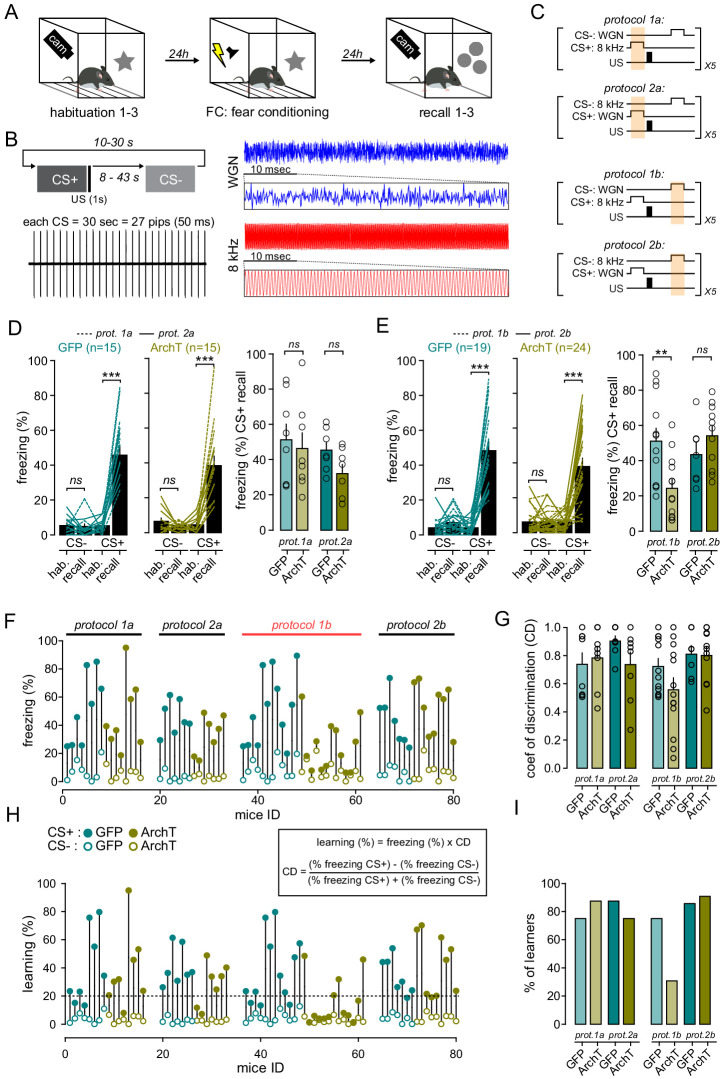
Effect of FrA opto-inhibition during conditioning on freezing responses and learning during recall.(A) Timeline of behavioral experiments. Random delays (between 10 and 60 s) between CS were used and one example is indicated below. (B) Fear conditioning is performed on day 2 by pairing the CS+ with a US (1 s foot shock, 0.6 mA, 5 CS+/US pairings). The onset of the US coincides with the offset of the CS+. The CS− is presented after each CS+/US association with random delays (8–43 s) and is never reinforced. The next pairing is performed after random delays (10–30 s) from the offset of the CS−. Each CS lasts 30 s and is composed of 27 pips of 50 ms presented at 0.9 Hz. The frequencies used for CS+ and CS− were counterbalanced across animals (protocols 1 and 2). (C) Fear-conditioning protocols. FrA neurons expressing ArchT (or GFP) were photo-stimulated during the presentation of CS+ (8 kHz for protocol 1a or WGN for protocol 2a) or CS- (WGN for protocol 1b or 8 kHz for protocol 2b). US, footshock. Photo-simulations (orange box) were given during CS+ (protocols 1a and 2a) or CS- (protocols 1b and 2b). (D) Left, effect of light during learning on freezing behaviors during recall as compared to habituation (hab.) in GFP-expressing mice (left; n = 15) and ArchT-expressing mice (right, n = 15). Turquoise and khaki lines represent individual mice. Right, freezing behaviors quantified during CS+ in GFP- and ArchT-expressing mice. Circles, individual mice. (E) Same representation as (D) but for experiments with photo-stimulations delivered during CS-. (F) Freezing responses during recall upon CS+ (filled circles) and CS- (open circles) in GFP (turquoise) and ArchT (khaki) expressing mice. Significant differences between GFP and ArchT-mice were seen only for protocol 1b (red). (G) Coefficient of discrimination (CD) was calculated as follows: CD = (CS+ % freezing- CS- % freezing) / (CS+ % freezing+ CS- % freezing). Circles, individual mice. (H) Learning index was quantified for each CS by multiplying the % of freezing in each condition by the corresponding coefficient of discrimination. Mice with a learning index below 20% (dotted line) were considered as non-learners. (I) Fraction of mice that learned the cue-shock association (learning >20%).